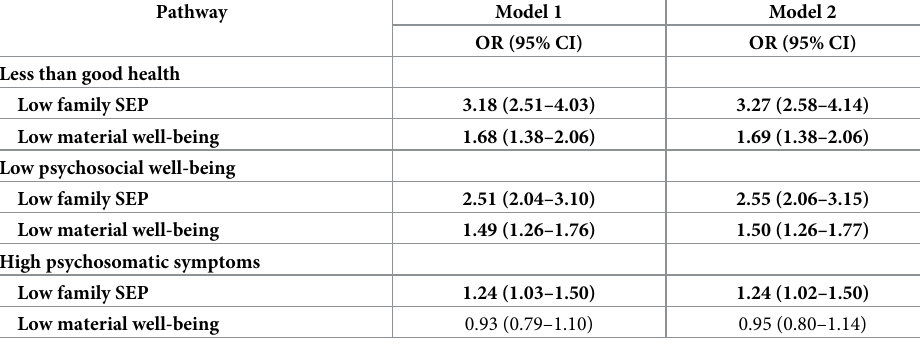
Table 2. Odds ratios (95% confidence interval) of poor health outcomes by two SES measures, adjusted for age, sex, and bullying victimization, without (Model 1) and with (Model 2) controlling for bullying perpetration.